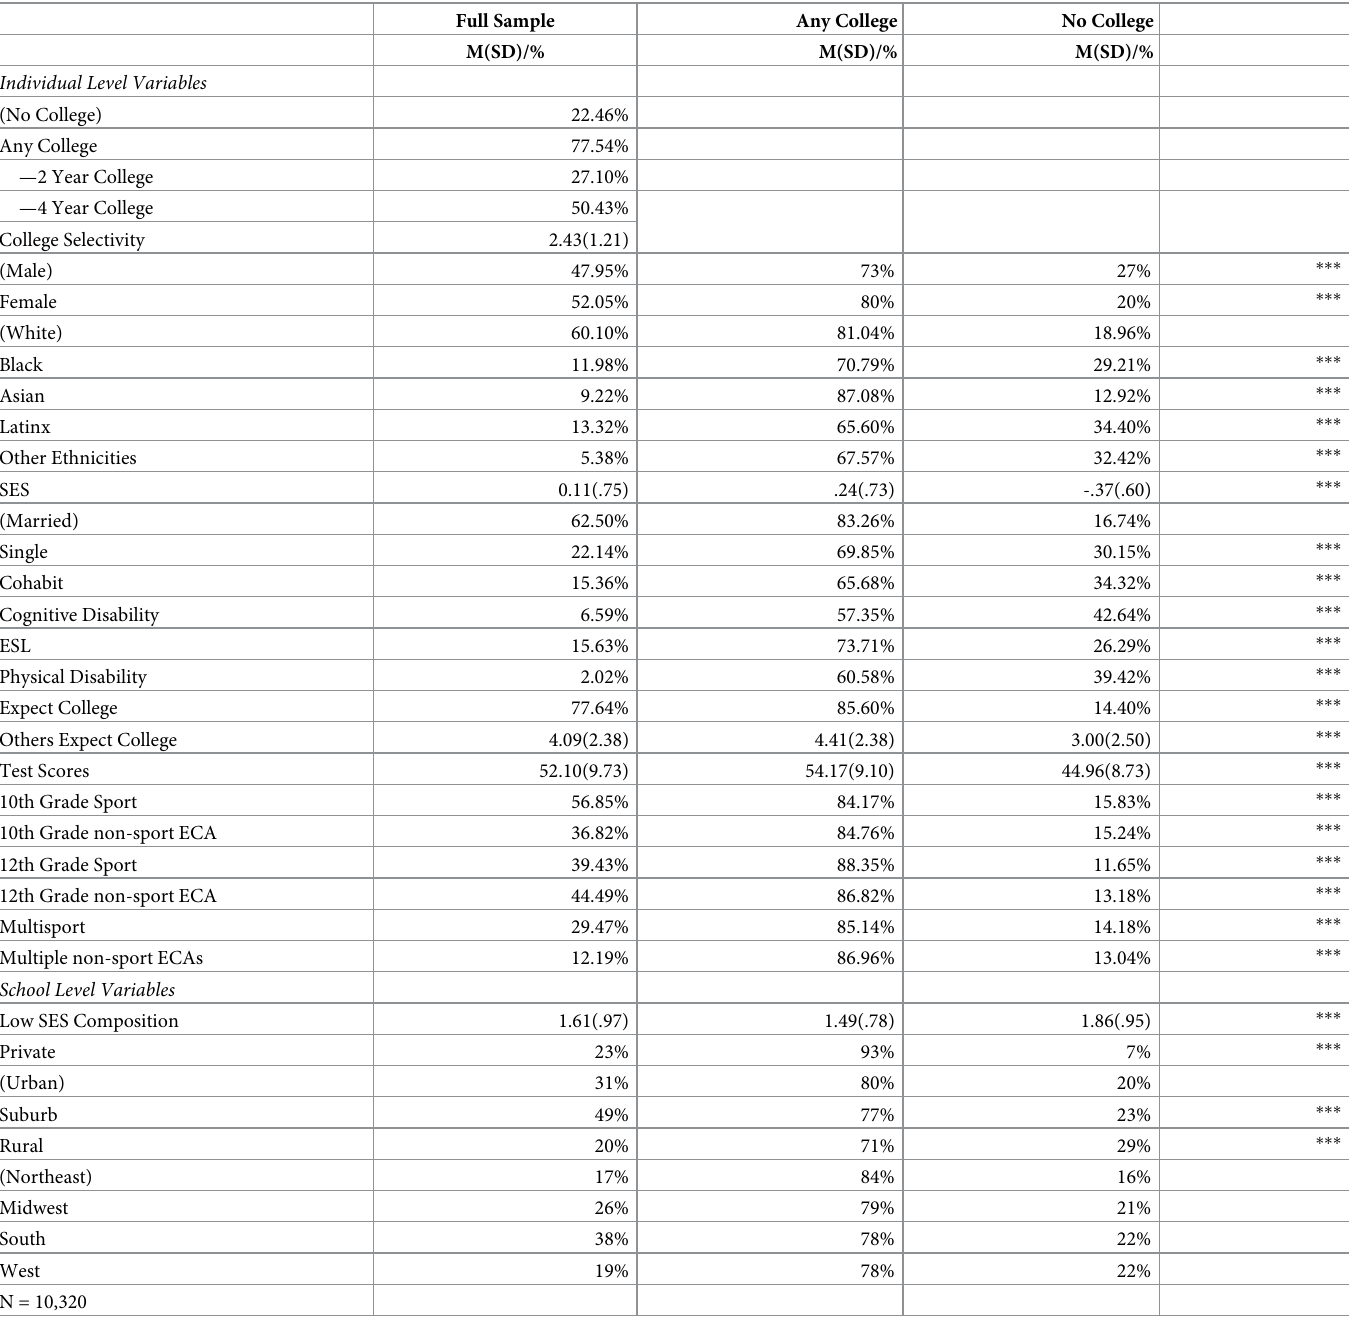
Table 4. Descriptive statistics for all variables used in the